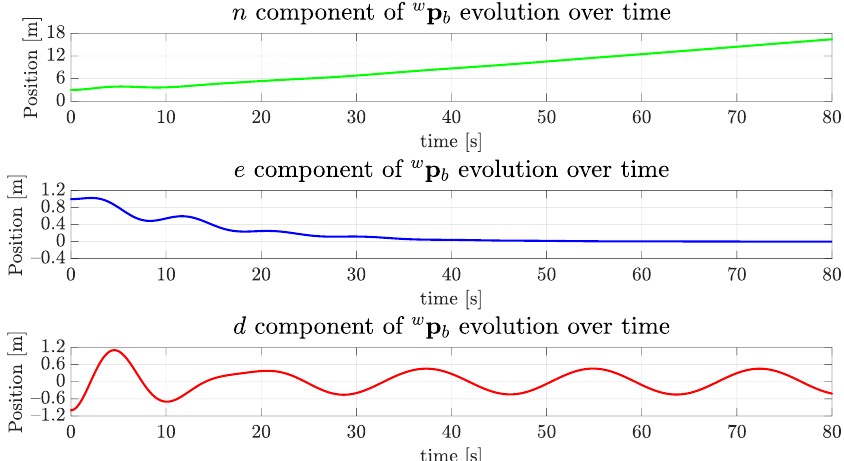
Figure 23. The evolution of the position components of the simulated vehicle over time for the sinusoidal